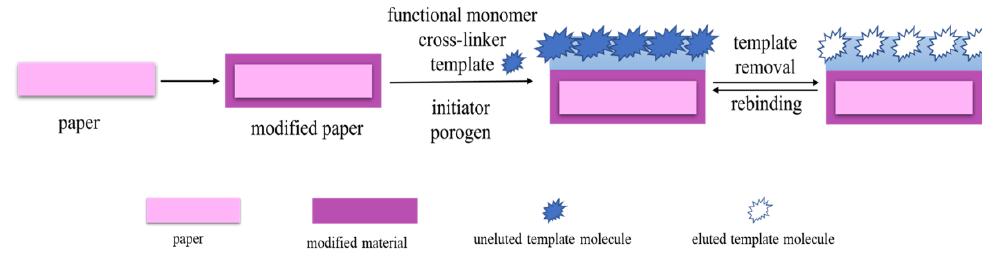
Figure 1. Preparation of MIP-PADs by in situ polymerization.